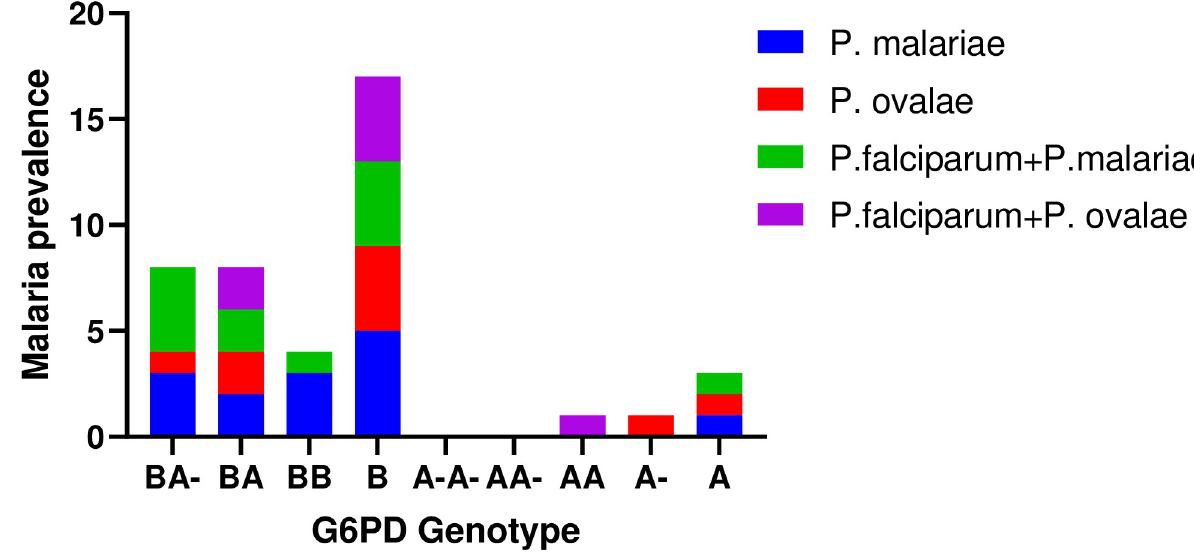
Fig 2. The prevalence of non-falciparum and or mixed falciparum infection among G6PD genotypic variants in Ghana.